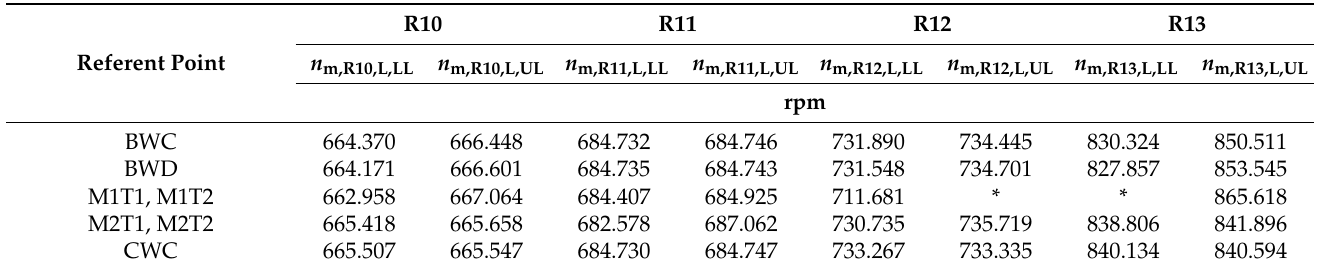
Table 12. Boundaries of the FREM resonant domains according to a L,per –EHO: